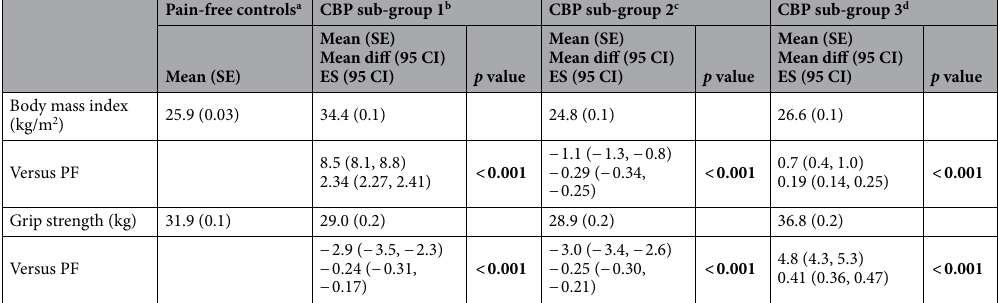
trols. Lastly, even though it was not used for deriving sub-groups, primary somatosensory volume was higher in sub-group (743.1 [601.0, 885.2]mm 3 , p < 0.001, ES = small) one and lower in sub-group two (− 1154.3 [− 1286.5, Clustering and classification validation. Step 8: Feature ranking and clustering was completed in train- ing set then applied to the test data set. Similar feature weight and clustering performances were observed across training and test data sets (Supplementary Figures 59–61; Supplementary Table 12). The Silhouette value for the training and test sets were 0.65 and 0.63, respectively (Supplementary Figures 62 and 63). The within-cluster distances ranged from 0.054 to 0.217 in the training data and 0.054 to 0.243 in the test data (Supplementary Tables 14 and 15). The between cluster distances ranged from 0.200 to 0.699 in the training data and 0.200 to